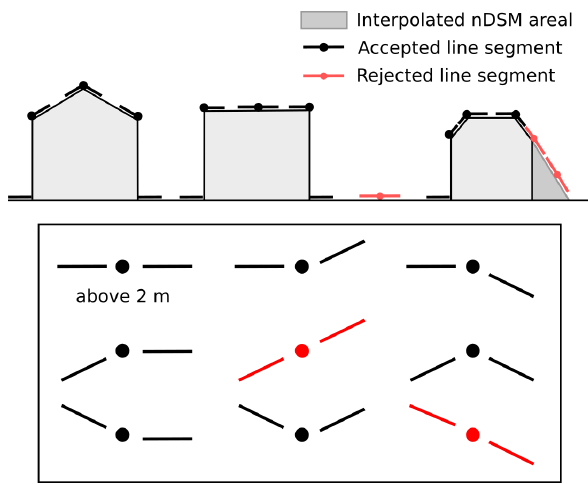
Figure 3: Principle of gradient classification. In the upper cross- section, black/red dots represent line segments while the lines to both sites are their respective gradients. Different gradient com- bination options are displayed below.